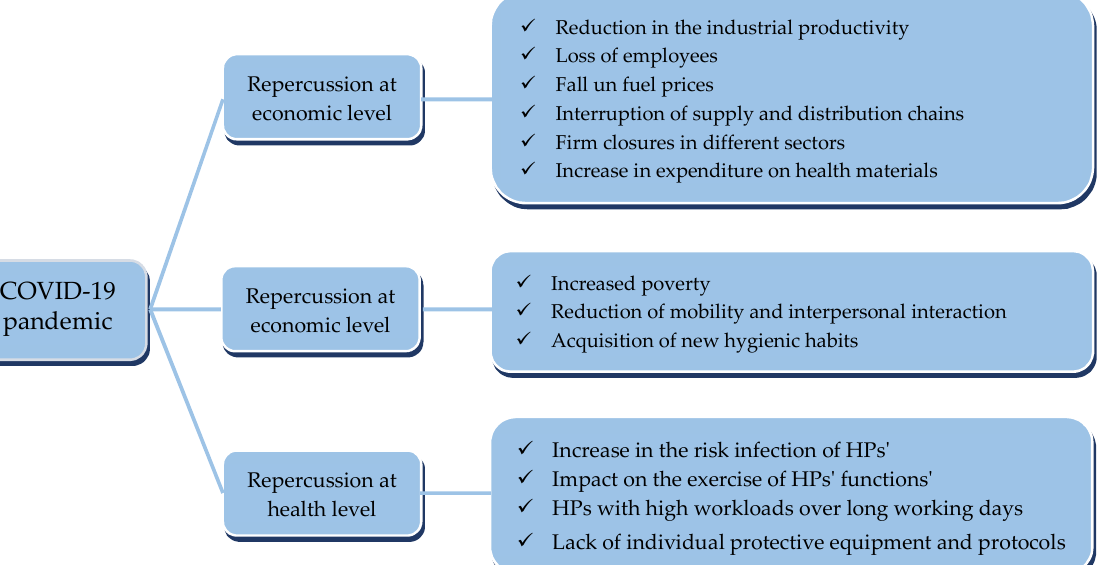
Figure 1. Diagram of the main repercussions of the COVID-19 pandemic.